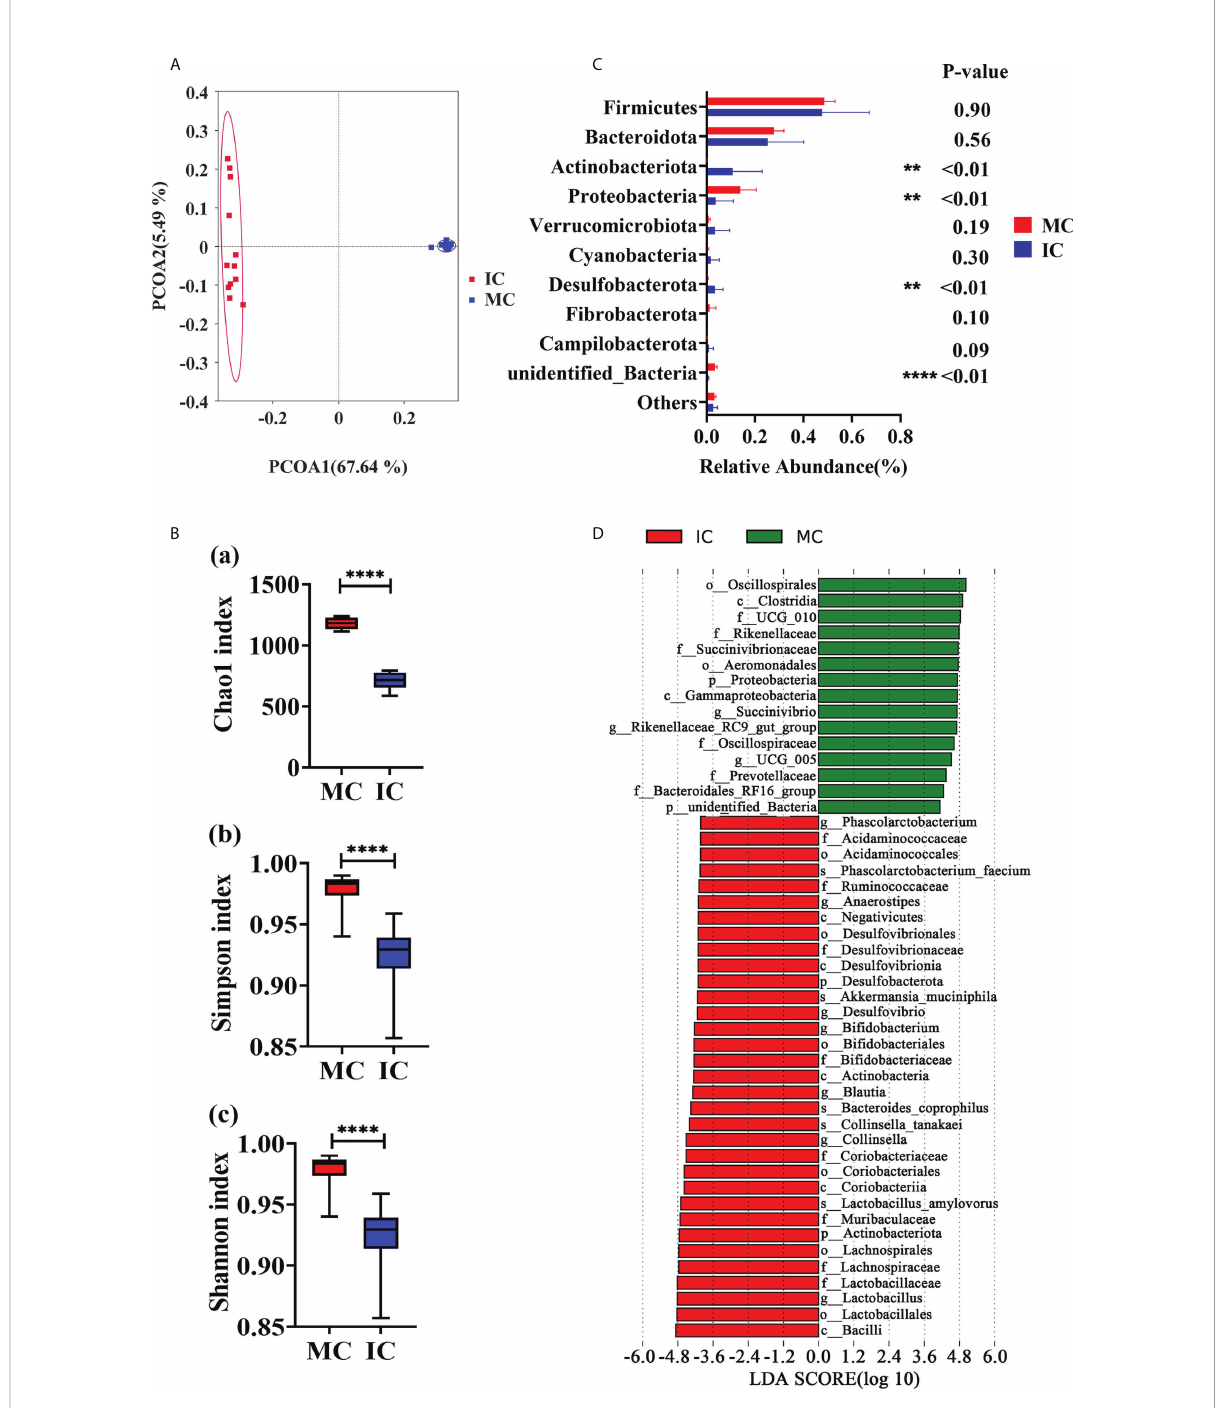
FIGURE 3 Comparison in fecal microbiome between adults and young goats. (A) Principal coordinate analysis (PCoA) of microbial based on unweighted UniFrac distances. (B) Alpha diversity (Chao1 index; Simpson index; Shannon index). (C) Relative abundance of top10 phyla. (D) Bar chart shows LDA score of young and adult groups. LDA score > 4. MC: feces of adult goats. IC: feces of young goats. The data were analyzed with unpaired t tests, and the data were expressed as mean ± SEM. ** P < 0.01, **** P <